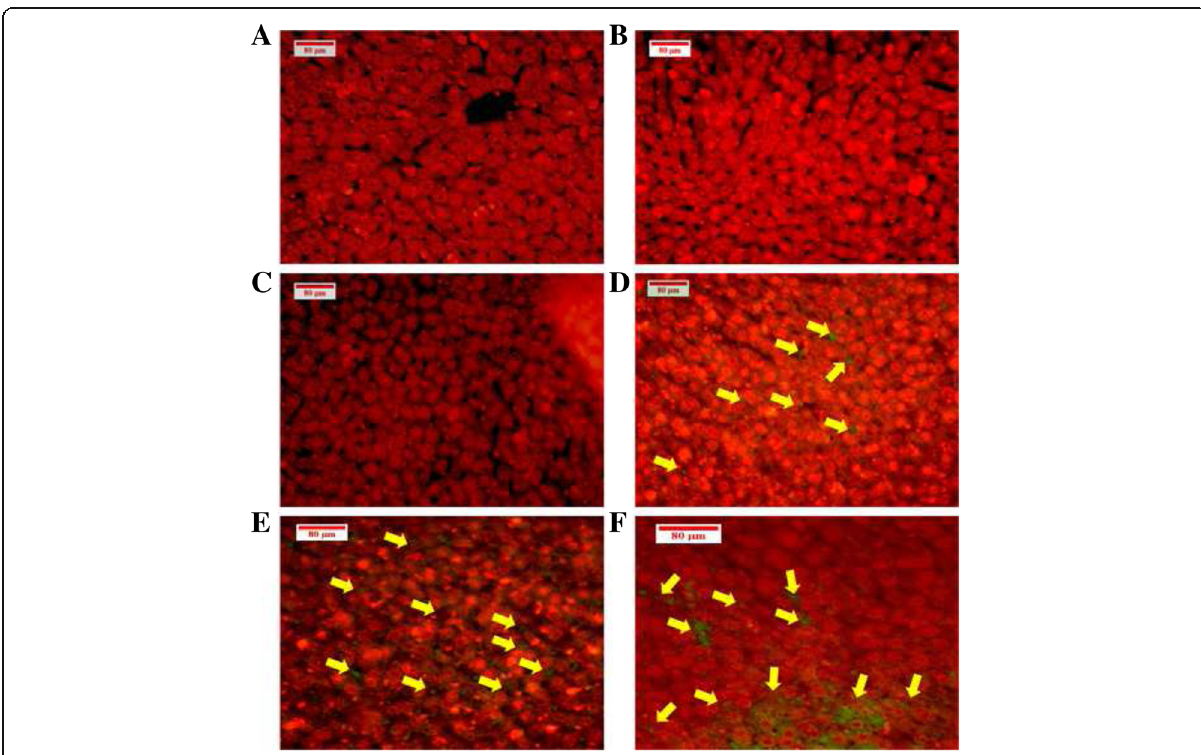
Fig. 15 TUNEL detection of the apoptotic cells in liver tissues. The green colour ( yellow arrows ) indicates the apoptotic cell in the liver of BALB/c mice in ( d ) of the 30 mg/kg, and ( e ) of the 60 mg/kg of BM treated groups, also ( f ) of vinblastine treated mice. a , b and ( c ) present healthy and leukaemic groups, respectively; clearly, no apoptotic cells were